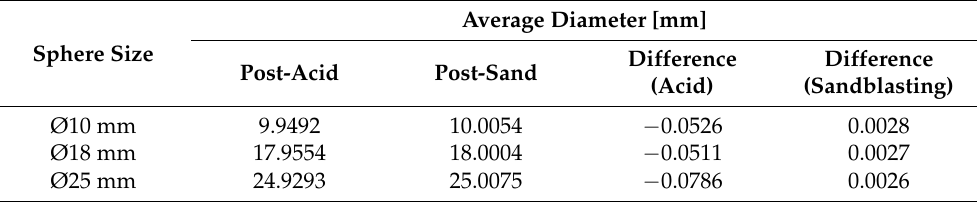
Table 3. Comparison of contact measurement results regarding diameter pre and post